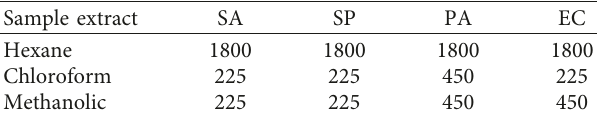
Figure 1: Graph for percent inhibition of DPPH radical of P. bleo crude extract and standard at different Table 2: Inhibitory concentration of MIC activity for crude extracts of Pereskia bleo.